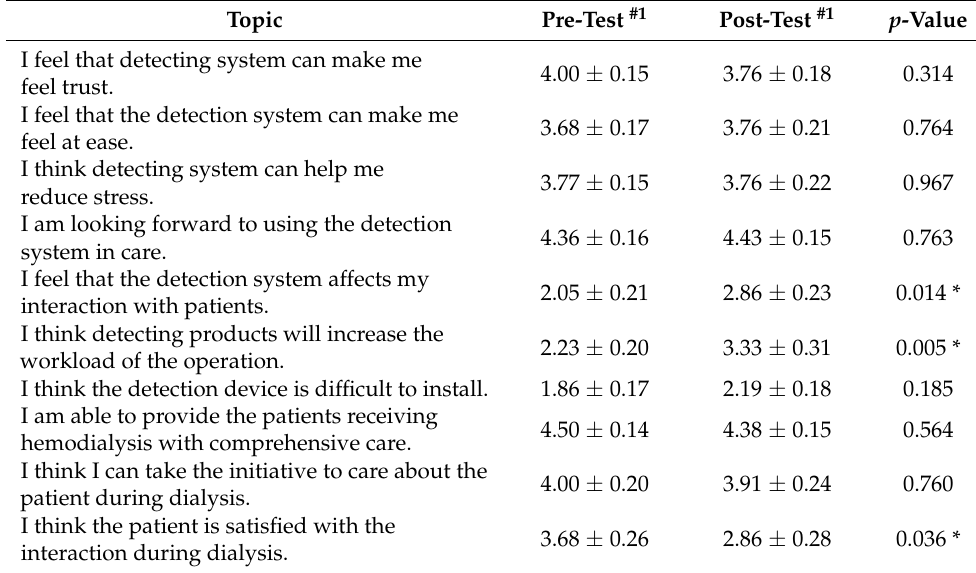
Table 3. The results of the questionnaires from the nursing staff.